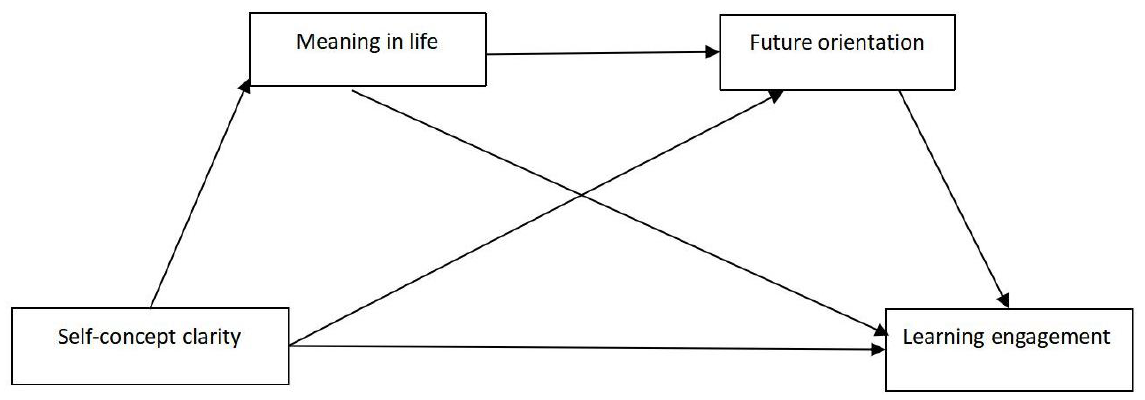
Figure 1. The conceptual multiple mediation model.